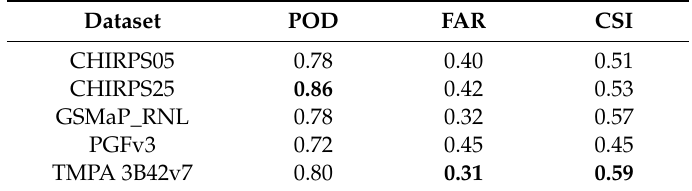
Table 6. Categorical performance scores of daily precipitations: POD (Probability of Detection), False Alarm Ratio (FAR), and Critical Success Index (CSI). The best values for each result statistical indicator are in bold.